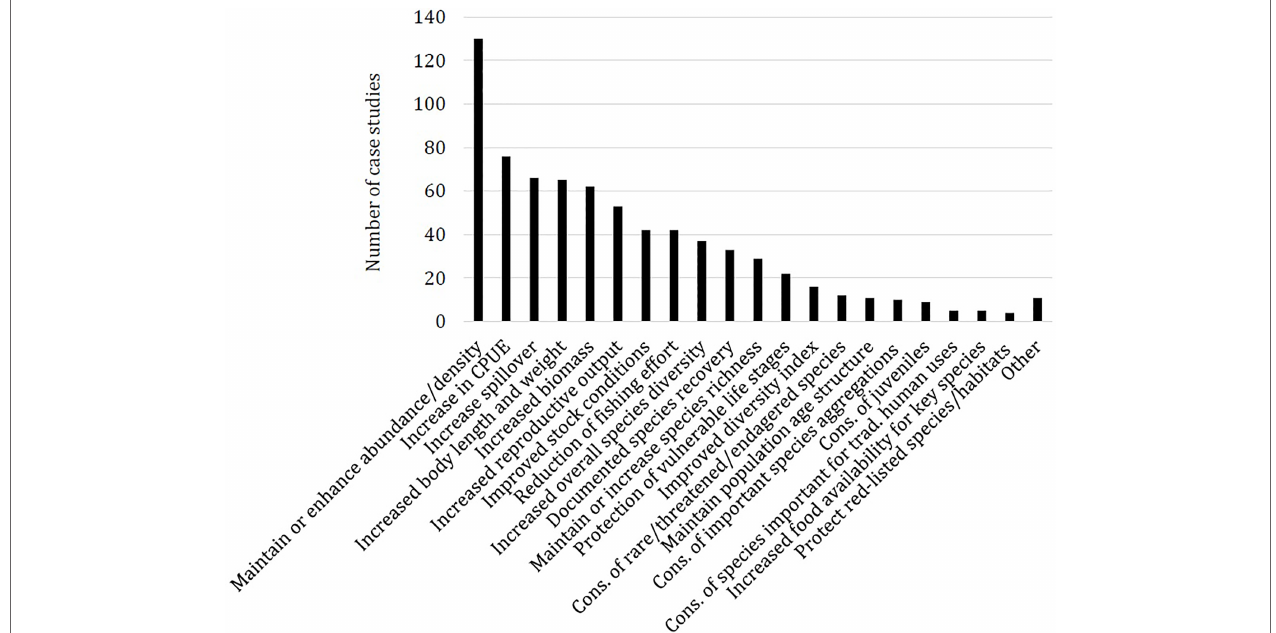
FIGURE 3 | Frequency of case studies for which population/species level biodiversity conservation outcomes were reported.